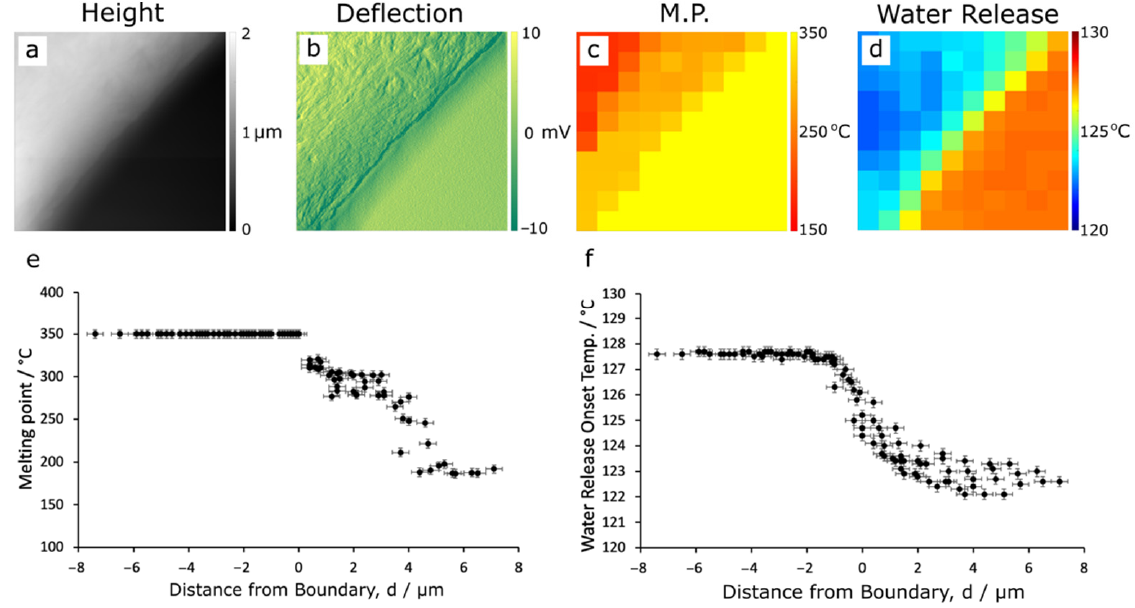
Figure 7. NanoTA analysis of PPB domains. ( a ) AFM height and ( b ) deflection maps. Corresponding microscopy images of the melting point transition ( c ) and water release onset temperature ( d ). Each pixel of these maps corresponds to 1 × 1 µ m 2 . Changes in the melting points ( e ), and water release onset temperatures ( f ) are also shown with the distance from the approximate mid-point of the transition region calculated from the thermal microscopy images.